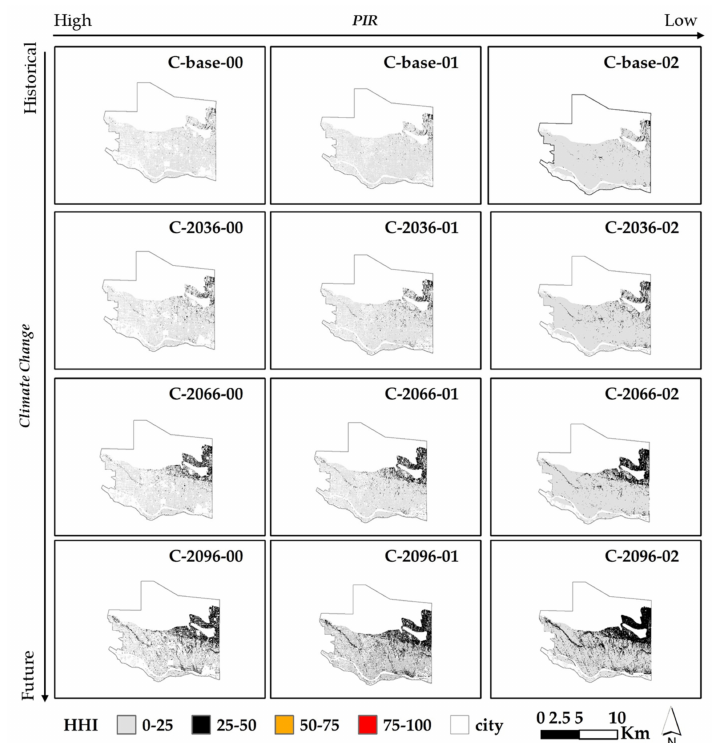
Figure 7. The HHI maps for Vancouver under di ff erent climate (base year, 2036, 2066, and 2096) and land cover scenarios (base, Scenario 1, and Scenario 2).